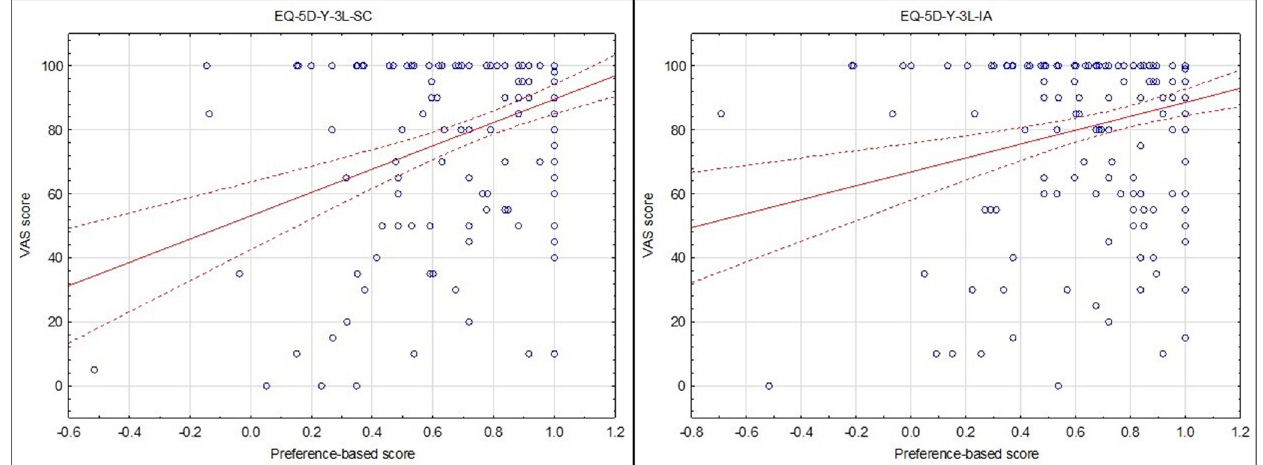
Figure 3. Scatterplot of utility scores versus VAS scores for the EQ-5D-Y-3L Self-Complete (SC) and EQ-5D-Y-3L Interviewer-Administered (IA) versions in children 8–10 years ( n = 207).